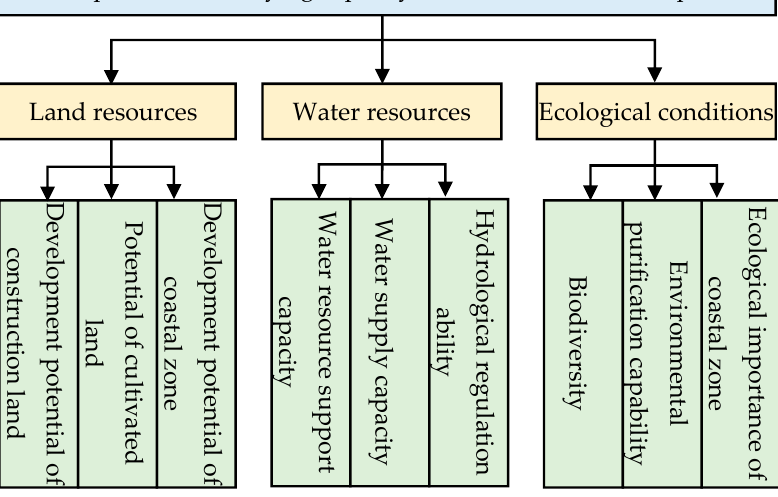
Figure 2. Evaluation index system of comprehensive carrying capacity of national territorial space.